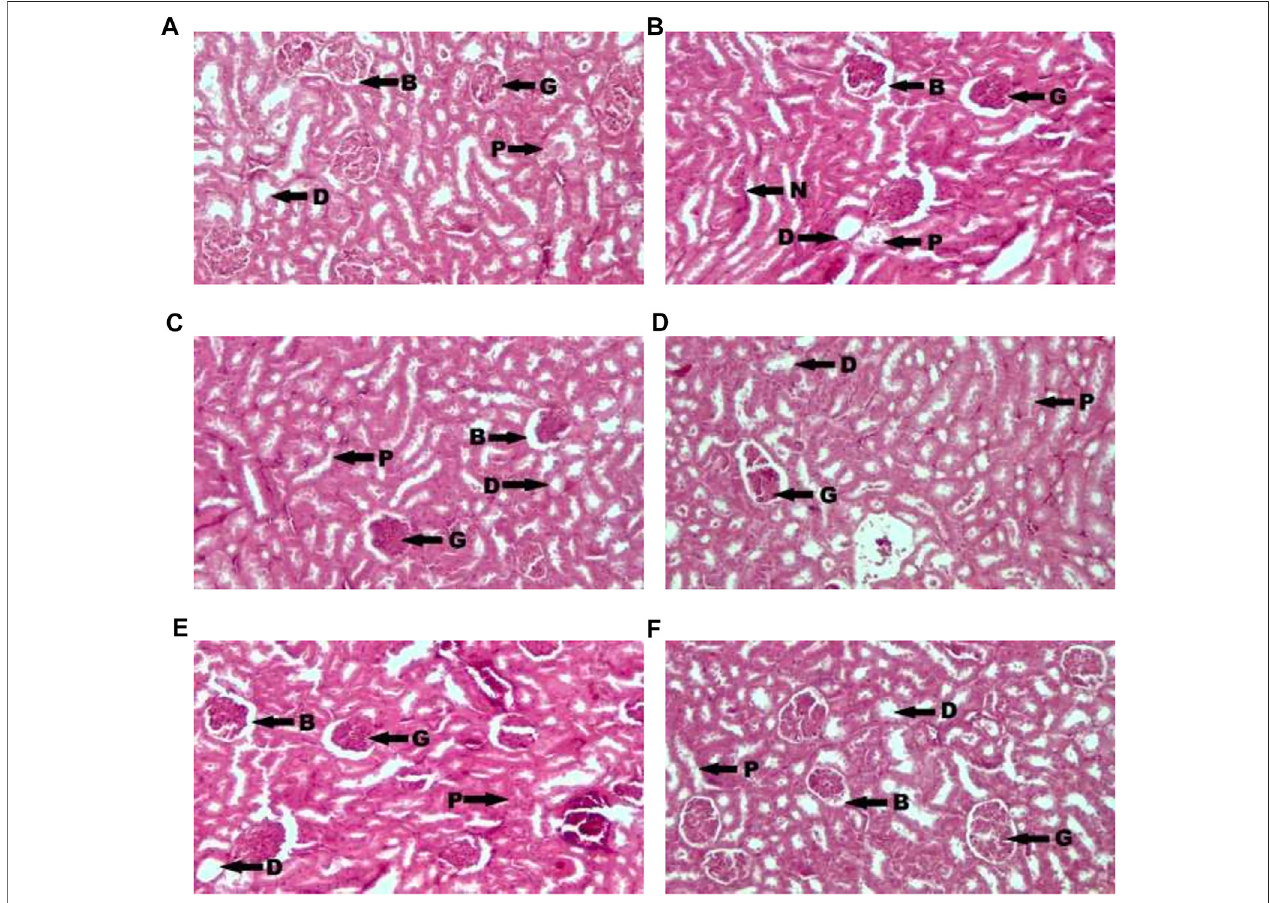
FIGURE 3 | Photomicrograph of a section of kidney of normal control (A) , diabetic control (B) , glibenclamide 20 mg/kg (C) , Spondias mombin 125 mg/kg (D) , Spondiasmombin250 mg/kg (E) ,Spondiasmombin500 mg/kg (F) .B-Bowman ’ scapsule,G-Glomerulus,P-Proximal convoluted tubule, D-Distalconvoluted tubules, and N-Necrosis. H&E